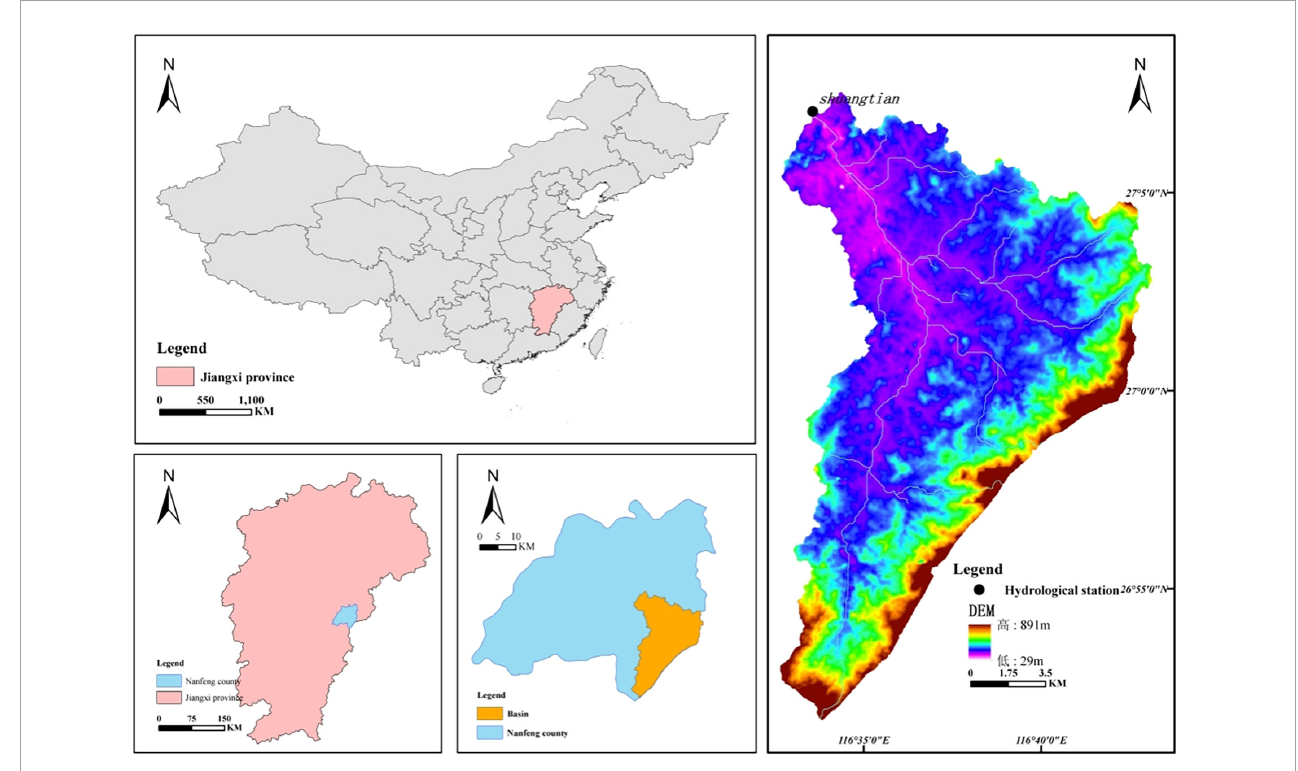
FIGURE1 Geographical location of the study